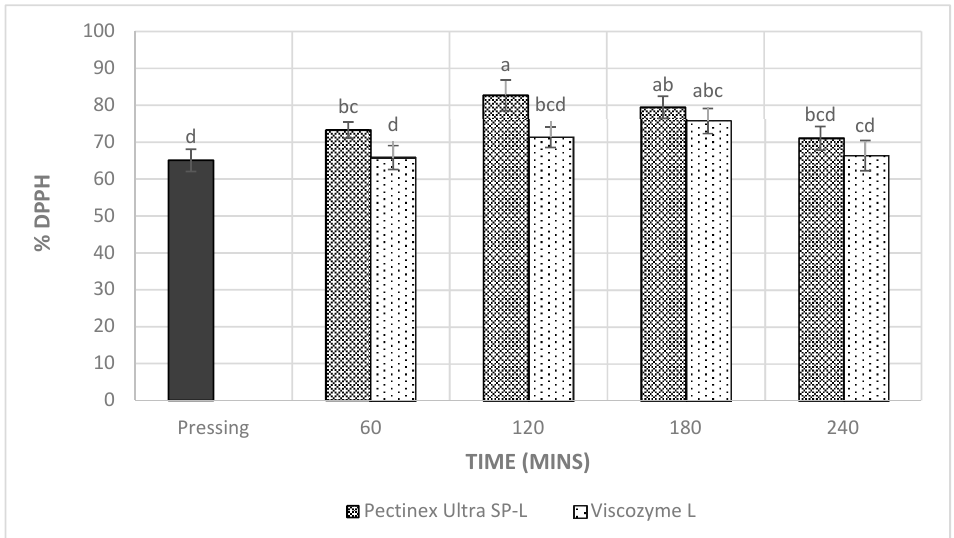
Figure 7. The effects of enzyme treatments on the antioxidant capacity of mulberry juice. The values are mean ± SD ( n = 3). Means sharing different letters are significantly different ( p < 0.05).